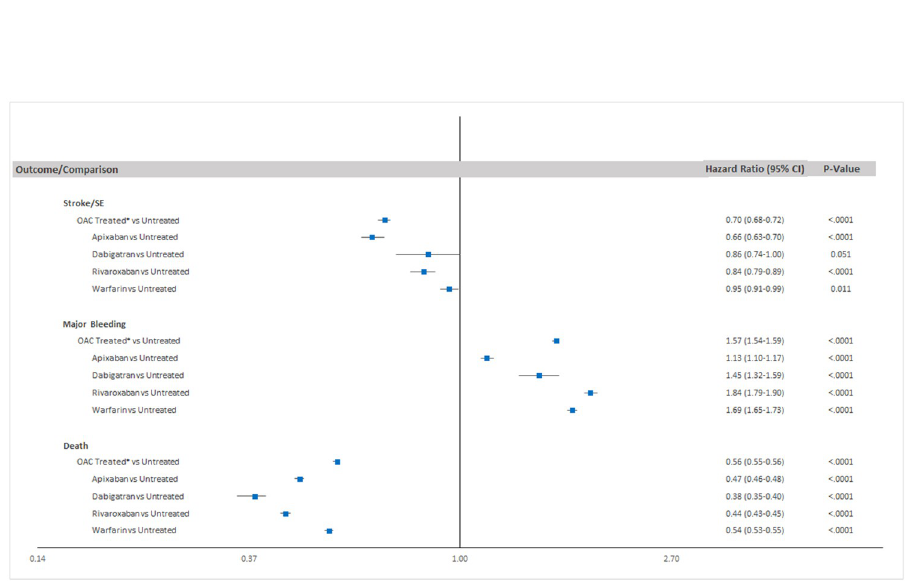
Fig 2. Adjusted risk of stroke/SE, major bleeding, and all-cause death based on OAC treatment after first atrial fibrillation diagnosis. Republished from Munir MB, Hlavacek P, Keshishian A, et al. Contemporary clinical and economic outcomes among oral anticoagulant treated and untreated elderly patients with atrial fibrillation. Heart Rhythm. 2021;18(8, S1 File): S431. doi: https://doi.org/10.1016/j.hrthm.2021.06.1064 under a CC BY license, with permission from Elsevier, original copyright 2021. � OAC Treated cohort includes apixaban, dabigatran, edoxaban, rivaroxaban, and warfarin treated patients; CI- Confidence Interval; OAC- Oral Anticoagulant; SE- Systemic